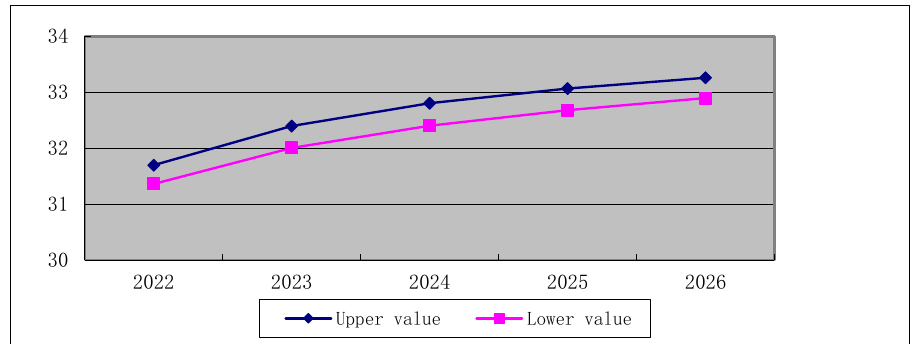
Figure 6. The variation interval of water requirement with the influence of primary industry in Tianjin.